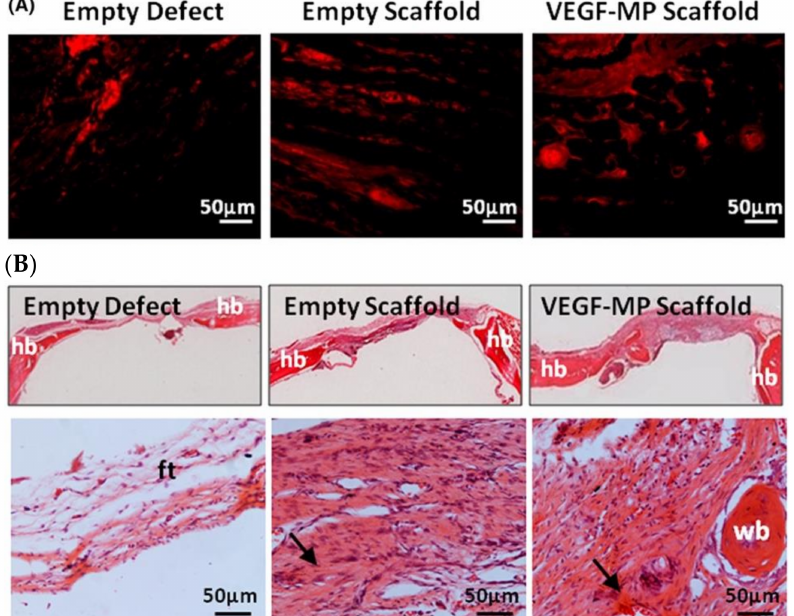
Figure 8. Immunobiological images of blood vessel formation and H&E sections. ( A ) Immunological images of endothelium labeled by CD31 (red). ( B ) H&E staining of empty defect, empty scaffold and VEGF-MP scaffold. HB, FT and WB for host bone, fibrotic tissue, and woven bone. Arrows indicated new bone formation. Reproduced from [135] with permission Copyright (2015) John Wiley & Sons, Ltd. Hoboken, NJ,